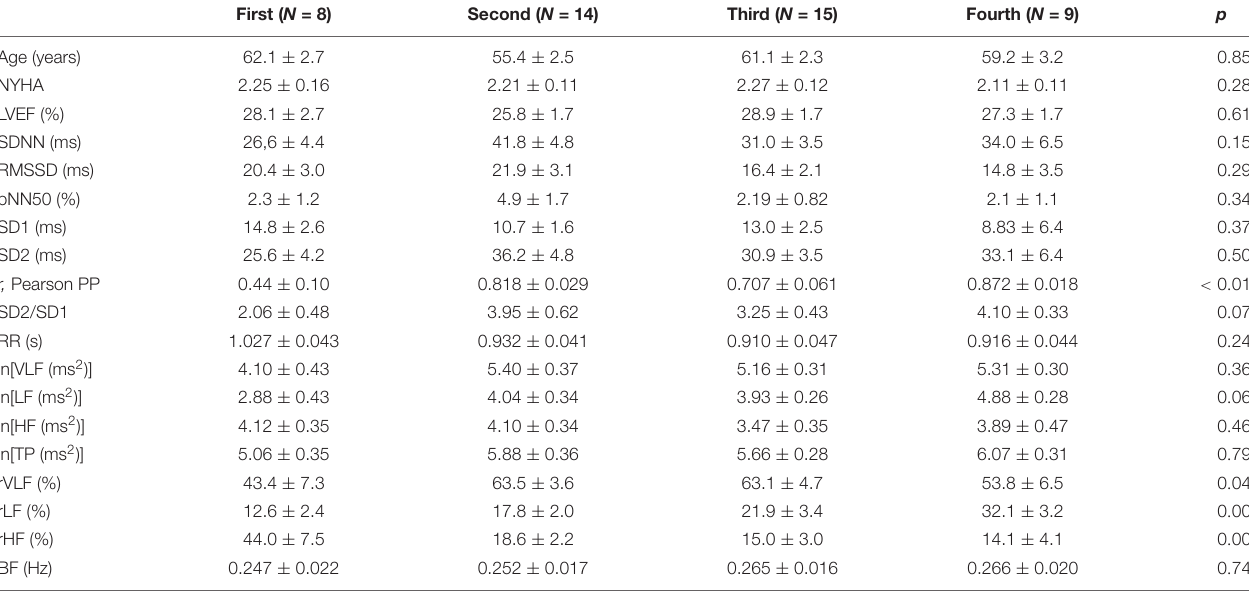
TABLE 6 | Comparison of clinical data, and linear and non-linear HRV measures between four clusters of heart failure patients. First ( N = 8) Second ( N =